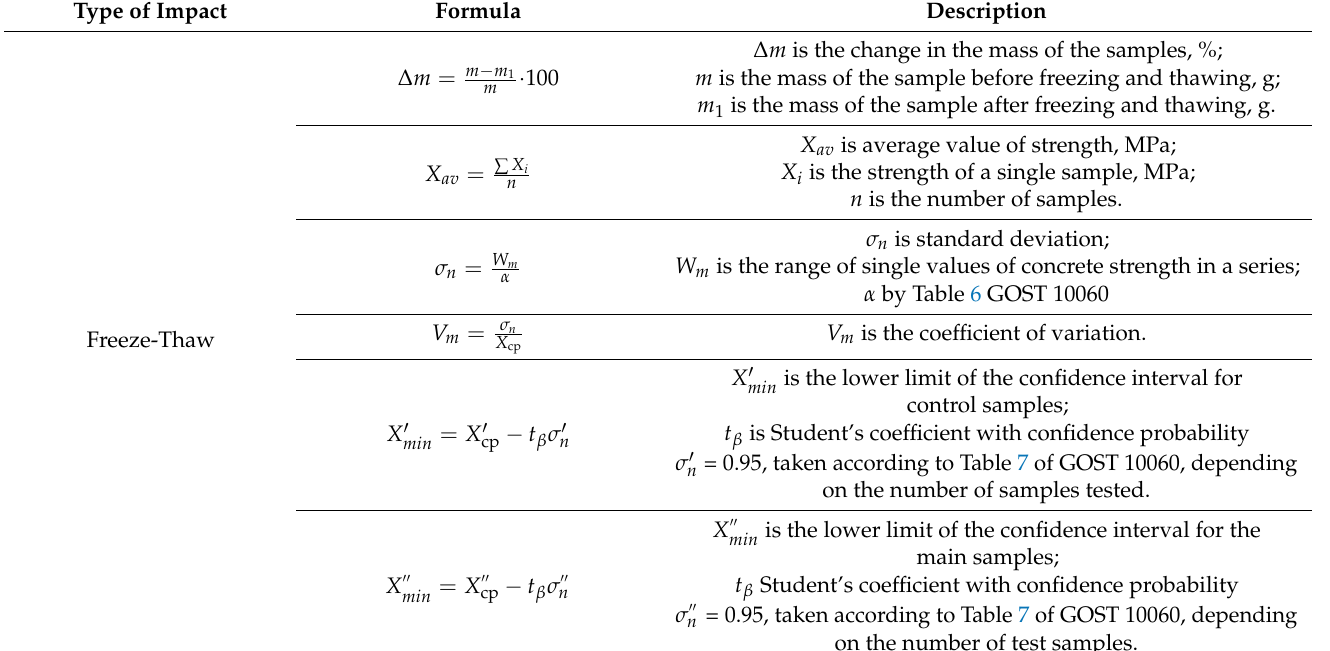
Table 7. Formulas for calculating the physical characteristics of vibrated and centrifuged concrete.